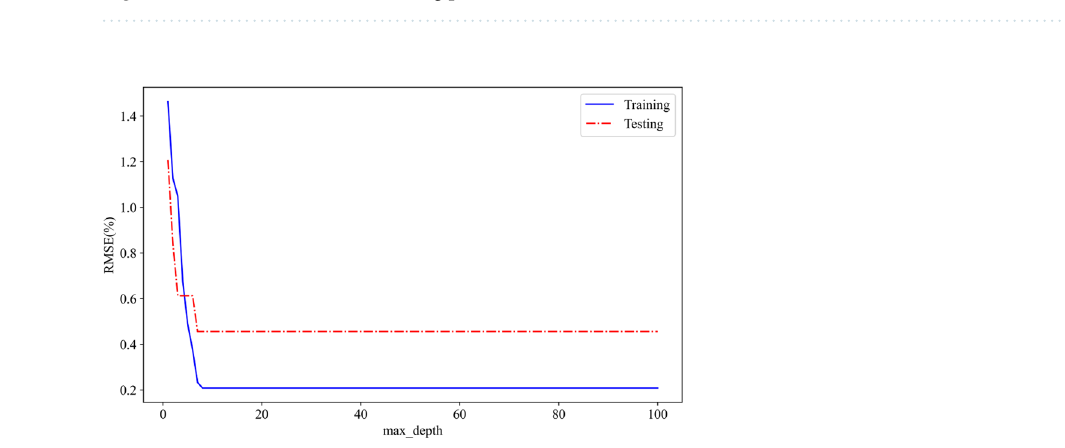
Figure 8. The RMSE curves of testing patterns under fivefold CV.